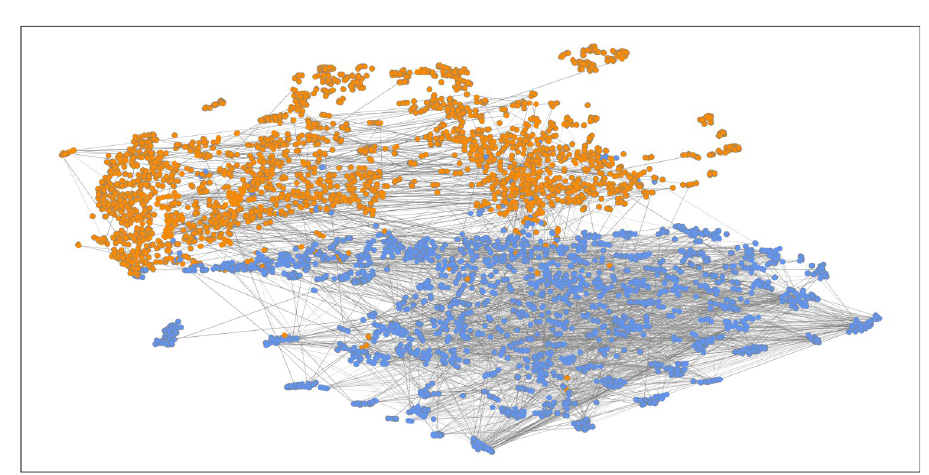
Fig 6. The visualization of the Weibo2021 posts and the weight coefficients of the meta-path PUP. The output node features obtained by the MHAN model’s attention layers are projected onto a two-dimensional plane, and the node color indicates the class of posts. The attention weight coefficients of the meta-path PUP between nodes are denoted by the edge thickness.